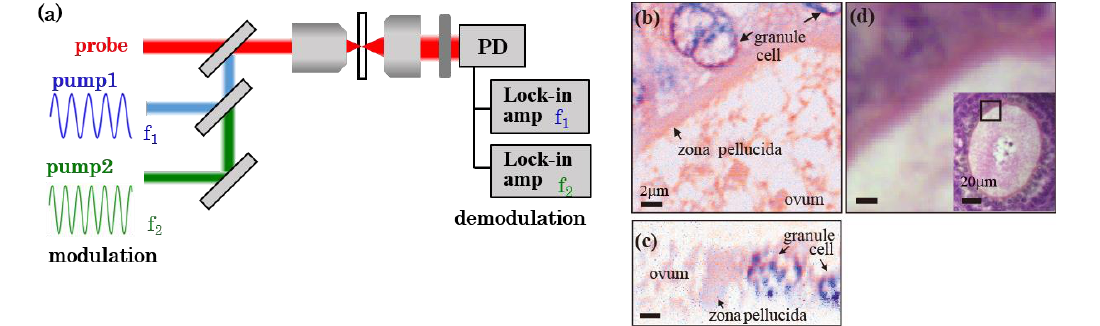
Figure 7. Simultaneous dual-wavelength photothermal imaging with the frequency multiplexing technique: ( a ) Schematic illustration of dual-wavelength photothermal imaging setup. Two pump beams were modulated at different frequencies. The signals were demodulated with multichannel lock-in amplifiers; ( b ) Dual-wavelength PT images of H&E stained biological tissue in the lateral ( b ) and ( c ) axial planes, respectively. ( d ) Bright field image of the tissue in the same area as that in ( b ).